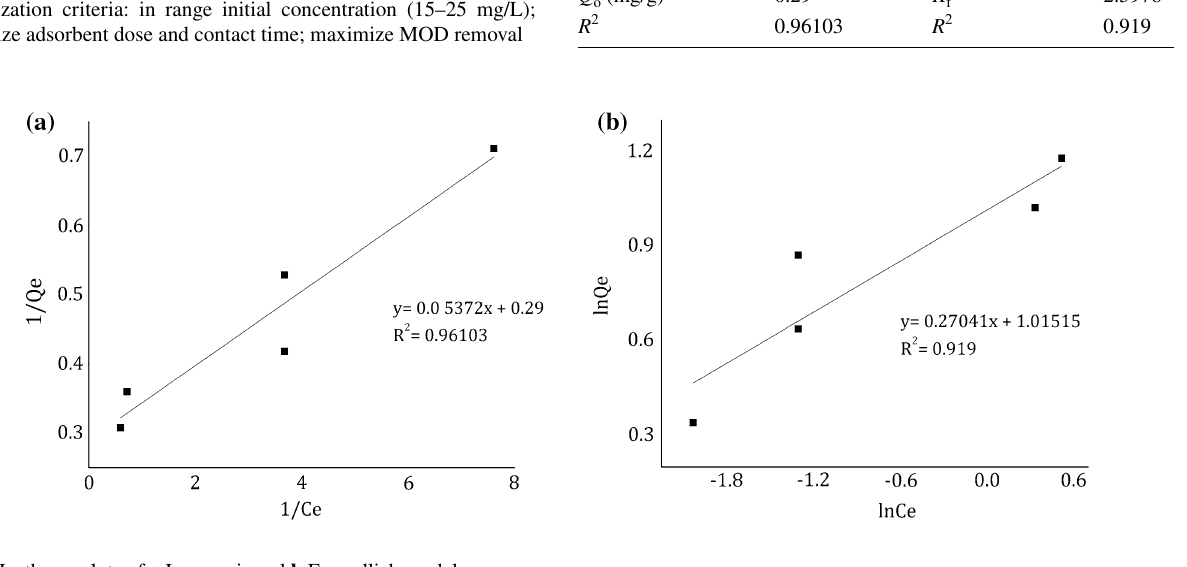
Fig. 5 Isotherm plots of a Langmuir and b Freundlich models